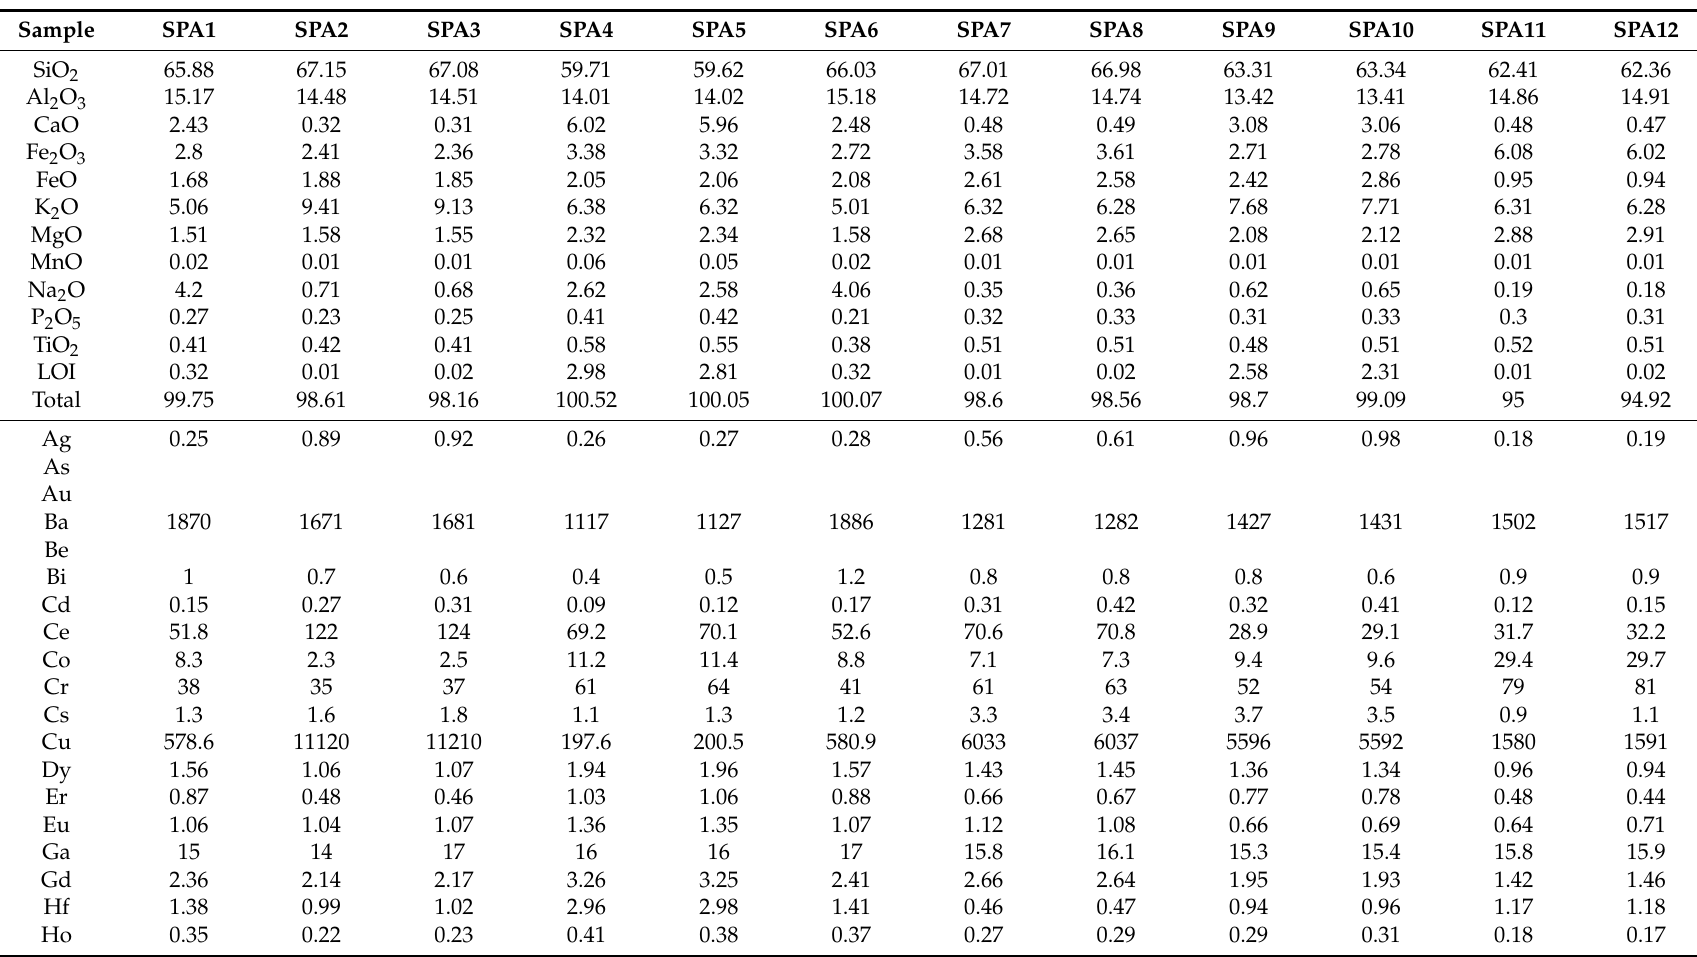
Table 6. Major oxide (wt %), trace element (ppm) compositions of lamprophyre dykes (LAM) and Sungun porphyry stock (SP) in the Sungun deposit ((A) analysis by